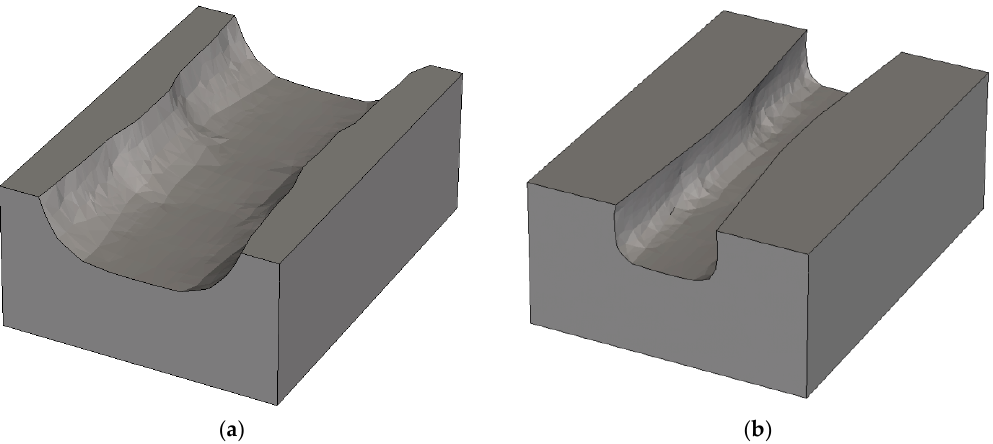
Figure 5. Simulation of oxide etching using the resist shape of Figure 4c as a mask. ( a ) Isotropic etching. ( b ) Anisotropic etching. To allow better visualization of the etched material, the resist mask is not shown. The lateral width of the simulation domain is 190 nm.